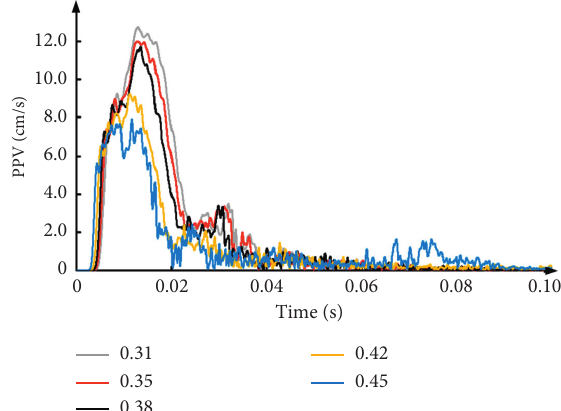
Figure 19: Changes of PPV of right wall with different Poisson’s ratio versus time.